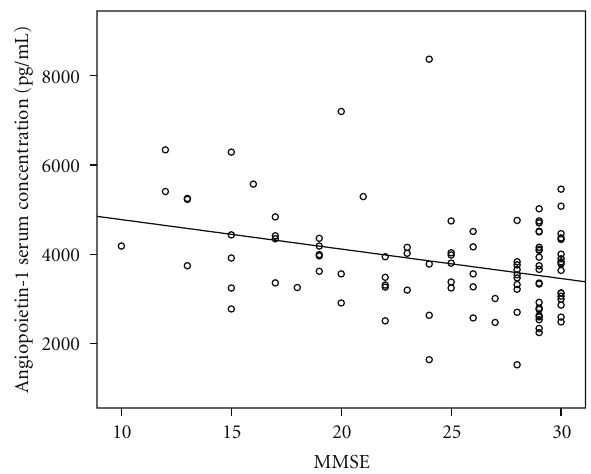
Figure 2: In all patients and healthy controls ( n = 102) there is a significant correlation between the MMSE score (as a measure for cognitive status) and Ang-1 serum levels ( r = 0 . 341; P < 0 . 001).